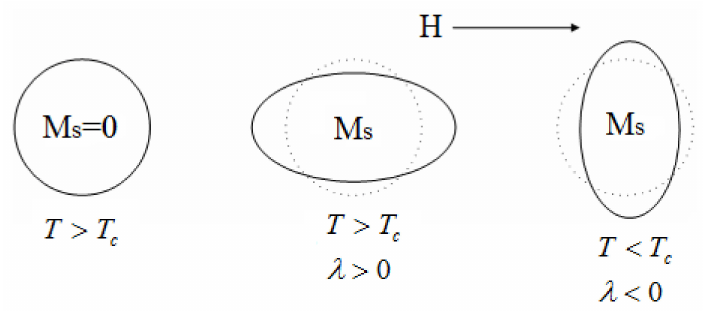
Figure 1. Spontaneous deformation